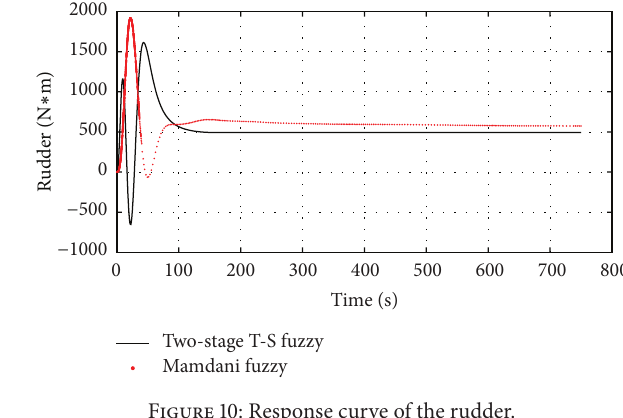
Figure 10: Response curve of the rudder.